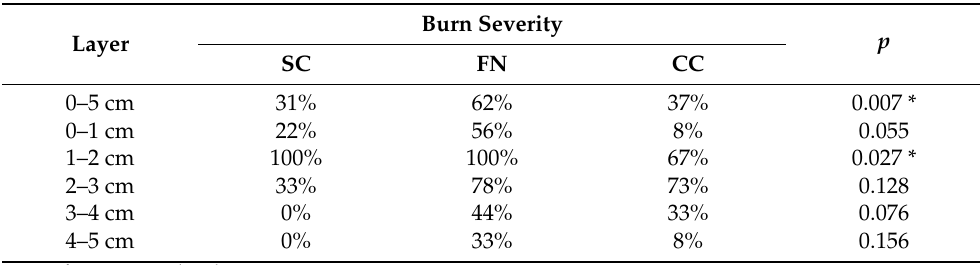
Table 2. Proportion of hydrophobic soils (MED classes 3–7) by soil depths and p values of Fisher’s exact test on burn severity.